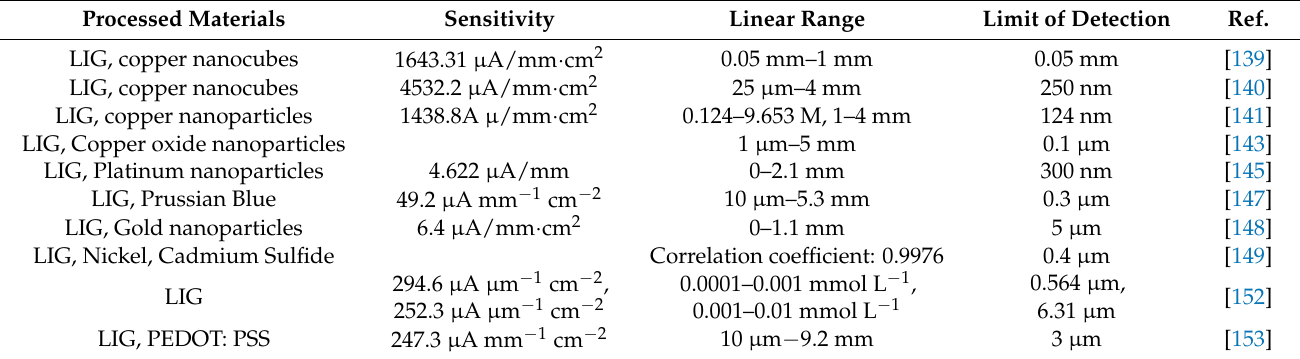
Table 6. Summary of the performance of the LIG-based sensors in terms of different sensing parameters. Processed Materials Sensitivity Linear Range Limit of Detection